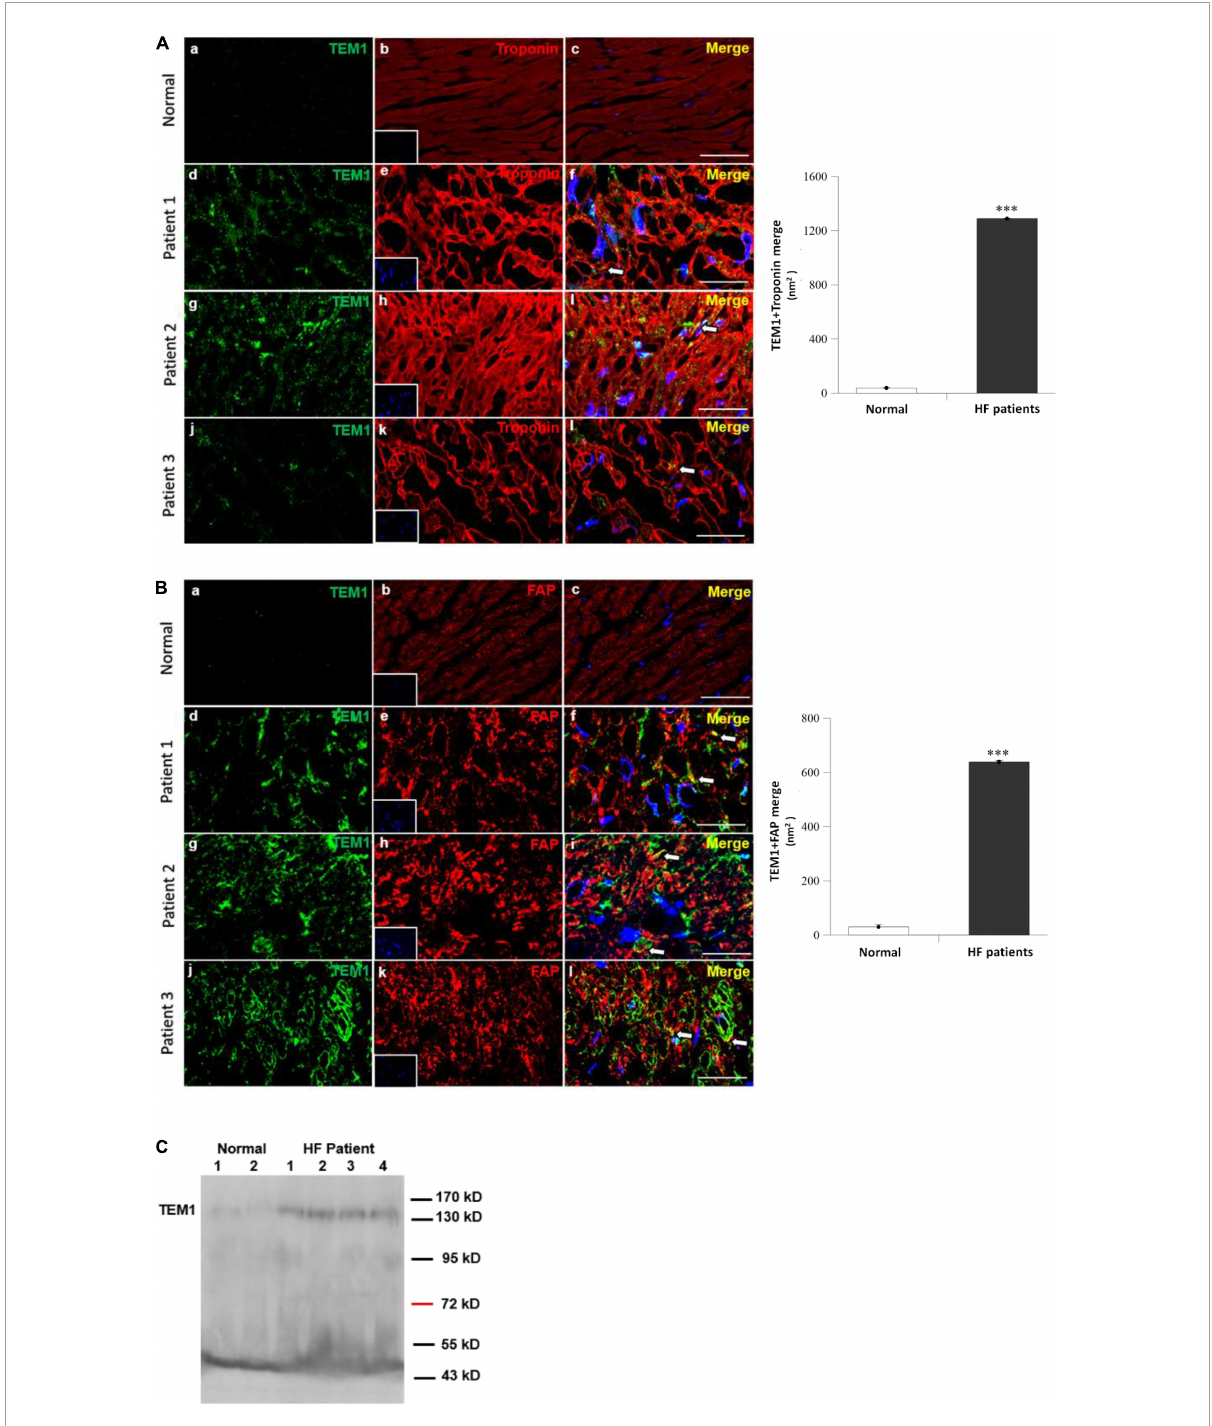
FIGURE1 Tumor endothelial marker 1 in human heart failure (A,B) . Immunofluorescence staining of TEM1 in normal right ventricular tissues and three patients with heart failure received endomyocardial biopsy. Representative images show immunostaining for TEM1 (green) and troponin (red, cardiomyocyte marker) (A) or TEM1 (green) and fibroblast-activation protein (red, FAP, cardiac fibroblast marker) (B) . Nucleus was stained with DAPI (blue). Arrows indicate the TEM1 staining (merge) in cells. Scale bar = 25 µ m. The area of positive TEM1 staining (merge) in randomly selected 4 sections in each patient and purchased samples were measured. The average value of the 12 sections of the three heart failure patients was compared with the control of normal ventricular tissue ∗∗∗ p < 0.001. Picture (a–c) : normal right ventricular tissue, picture (d–f) : patient 1, picture (g–i) : patient 2, and picture (j–l) : Patient 3. (C) Detection of sTEM1 in human plasma with western blotting in 4 heart failure patients and 2 normal healthy